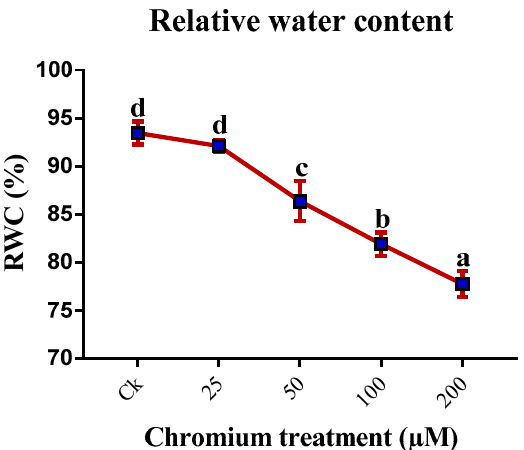
Figure 1. Effect of Cr on the RWC of the sweet potato. Means followed by different letters indicate a significant difference ( p < 0.05) among the five treatments according to the Tuckey test. Error bars show mean ± SE.